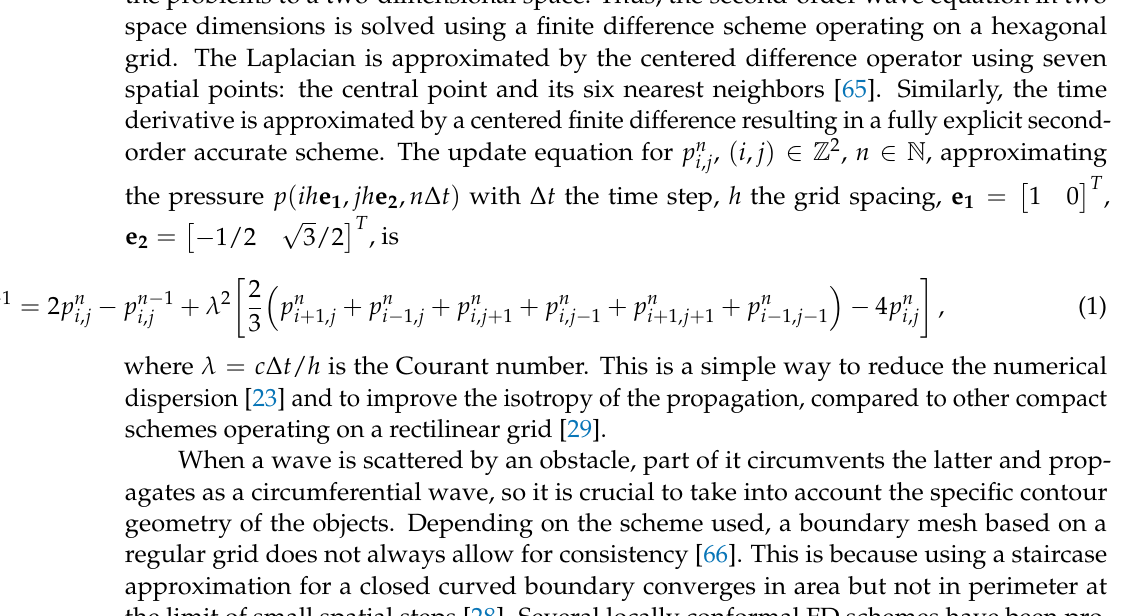
Figure 3d. The prismatic piers formed by the union of the arcades and vaults dosserets (Dosseret: Pilaster used as a straight jamb for an arch.) are supplemented by detached colonnettes at each re-entrant corner, separated by a distance of 1